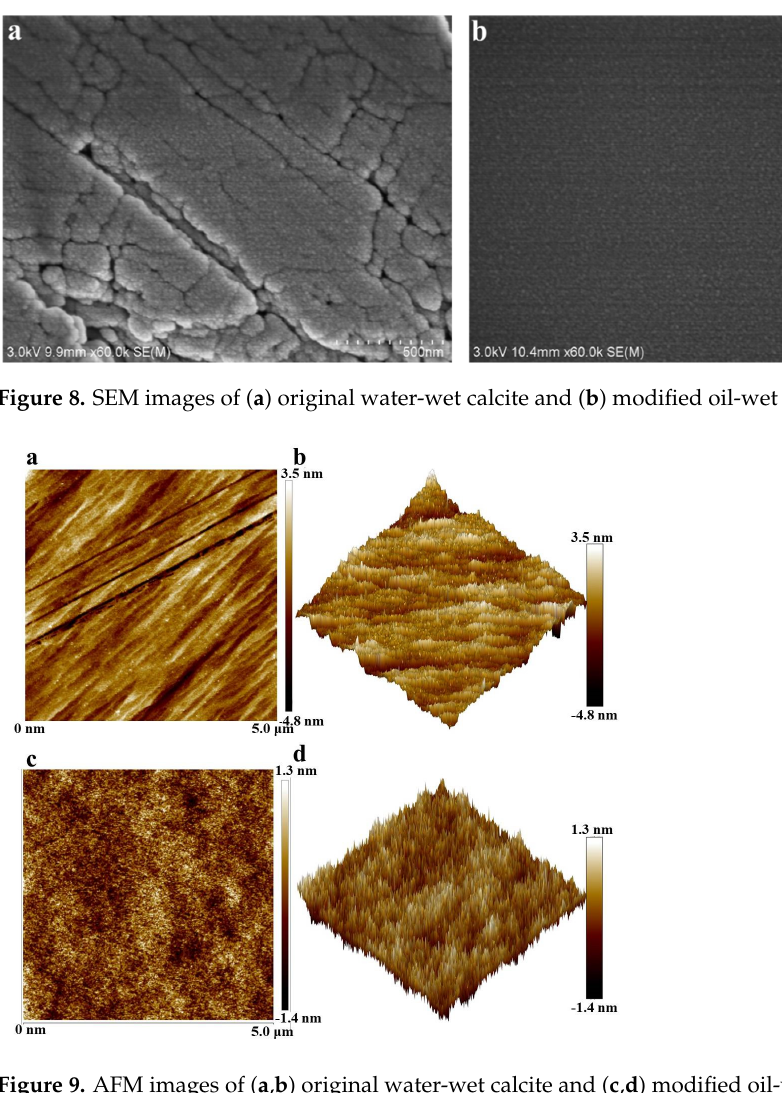
Figure 9. AFM images of ( a , b ) original water-wet calcite and ( c , d ) modified oil-wet